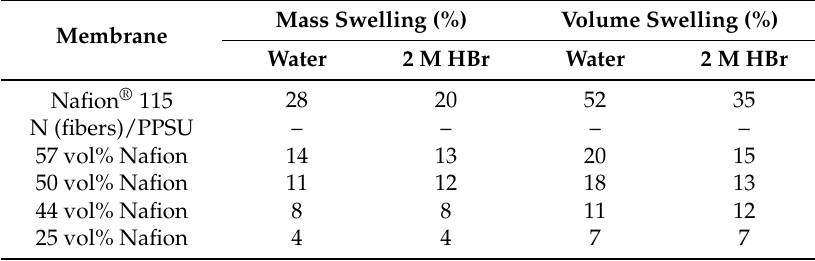
Table 1. Swelling in water and in 2 M HBr at 25 ˝ C of Nafion/PPSU composite membranes and Nafion ® 115.